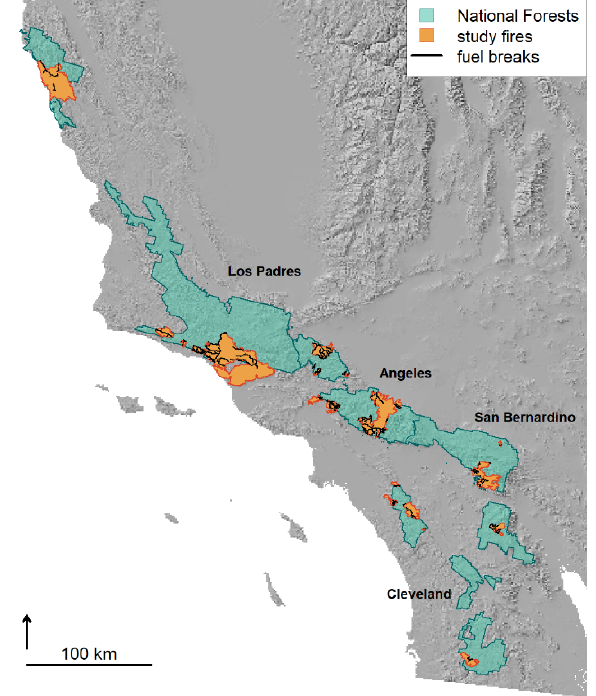
Figure 1. The study area includes the Angeles, Cleveland, Los Padres, and San Bernardino National Forests in Southern California. This map also shows the study wildfires and fuel breaks.